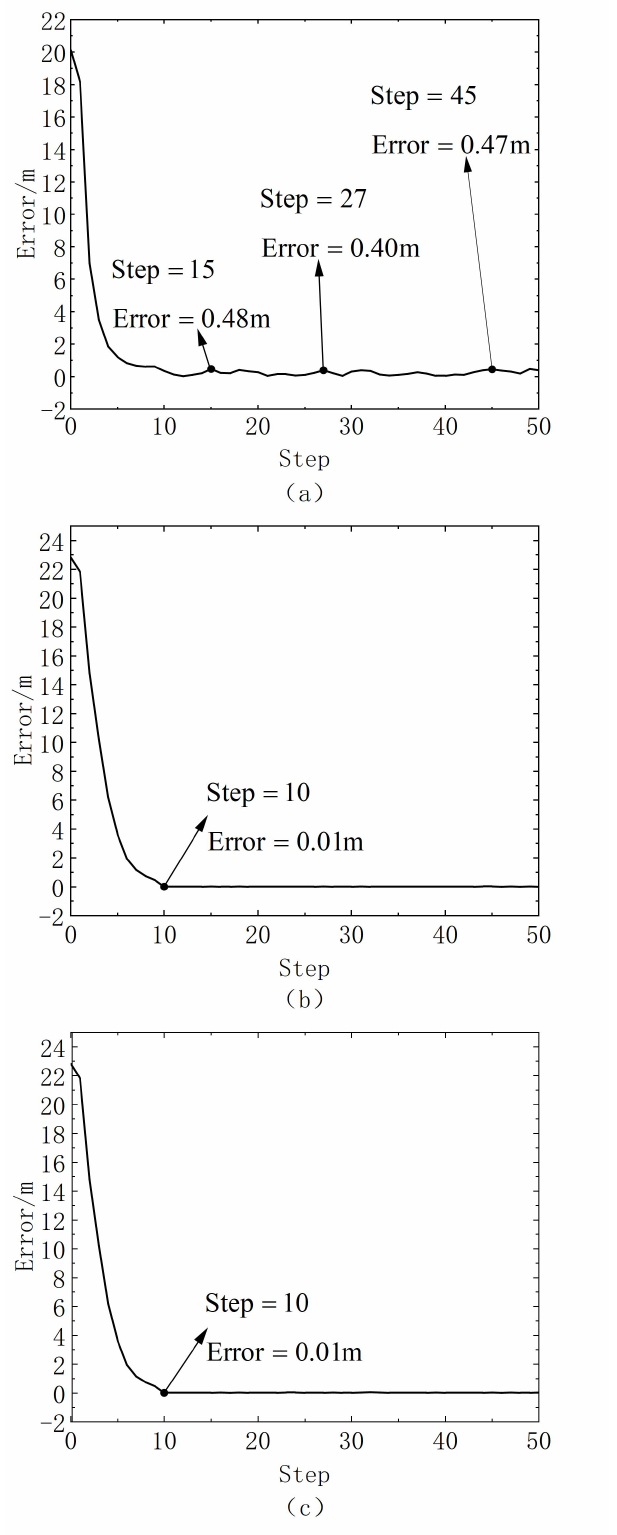
Figure 9. Drop point control error considering constant horizontal wind and ship motion disturbances: ( a ) based on nonadaptive fuzzy controller under actual ship motion disturbances; ( b ) based on double adaptive fuzzy controller under actual ship motion disturbances; ( c ) based on double adaptive fuzzy controller under predicted ship motion